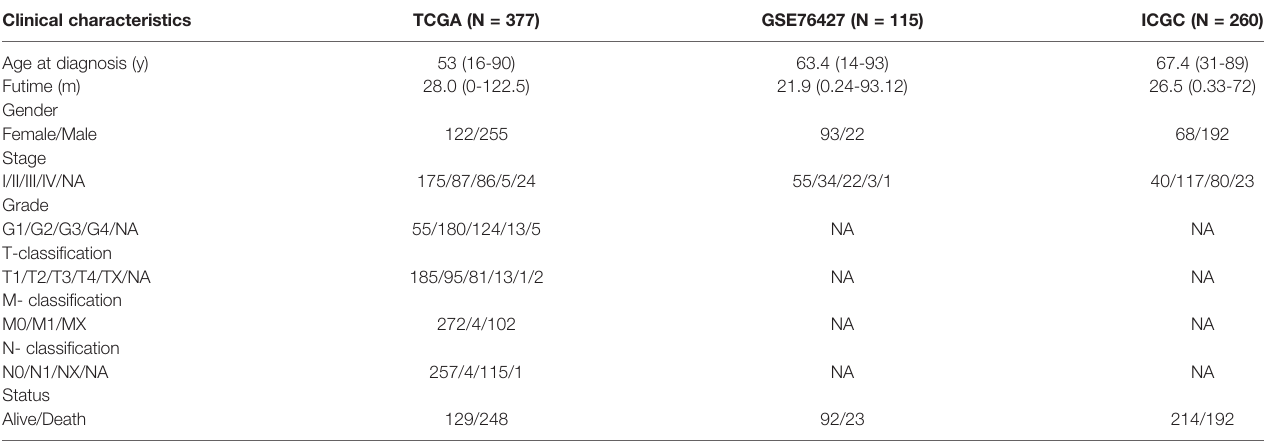
TABLE 1 | The clinicopathological characteristics of HCC patients based on the TCGA, GEO and ICGC databases. Clinical characteristics